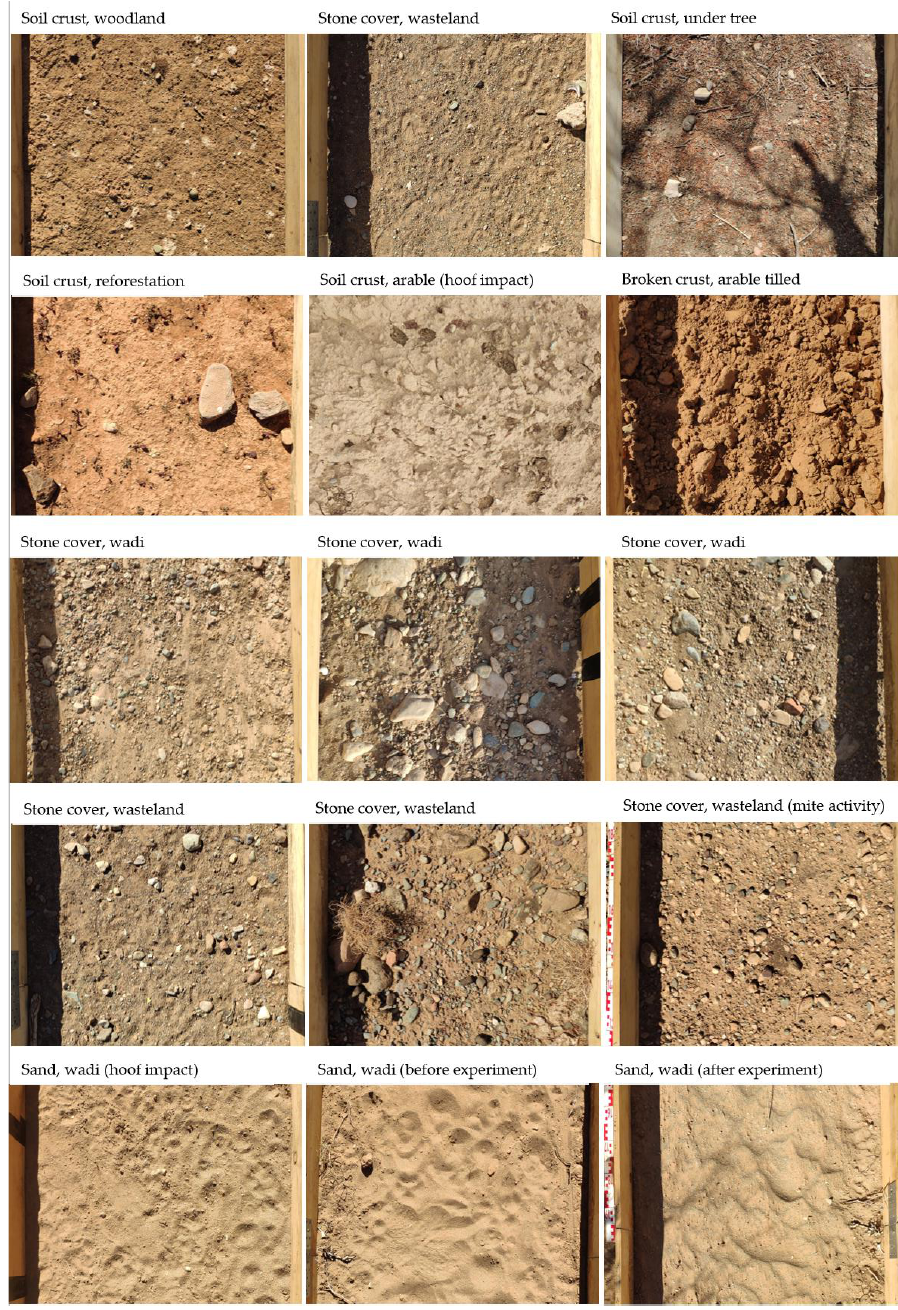
Figure 4. Tested surfaces (selection).